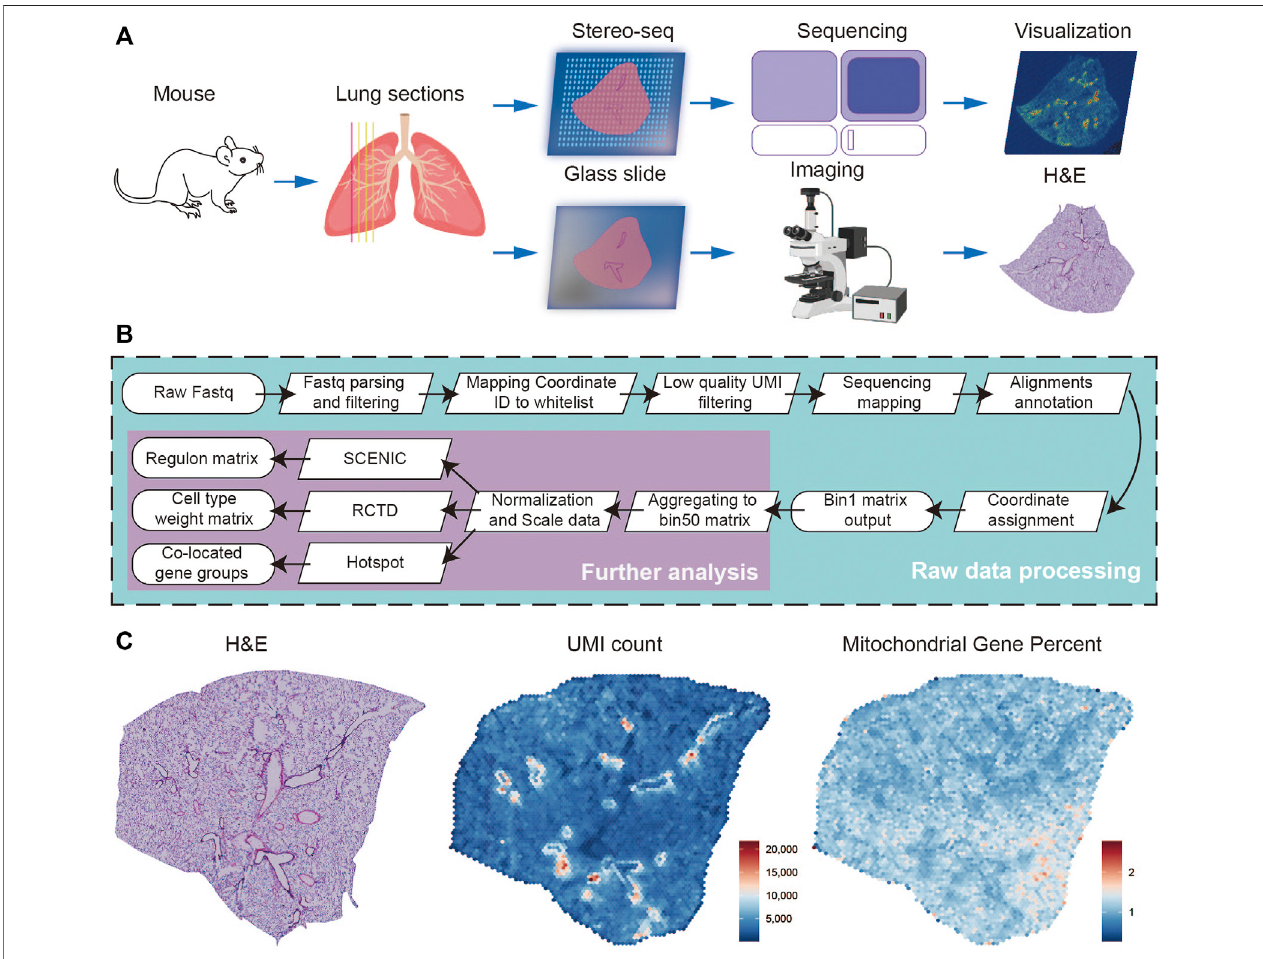
FIGURE 1 | Overview of the experimental, data analysis work fl ow, and Stereo-seq data quality control. (A) Four lung sections from female mouse were collected, and the fi rstwasstainedwithH&E,thesubsequentthreeforStereo-seq experiments. (B) Theanalysiswork fl owforStereo-seq datasets. (C) TheH&Eofthe fi rstsection (left), the UMI (middle), and the percent of mitochondrial genes (right) spatial distribution patterns of the fi rst Stereo-seq section.